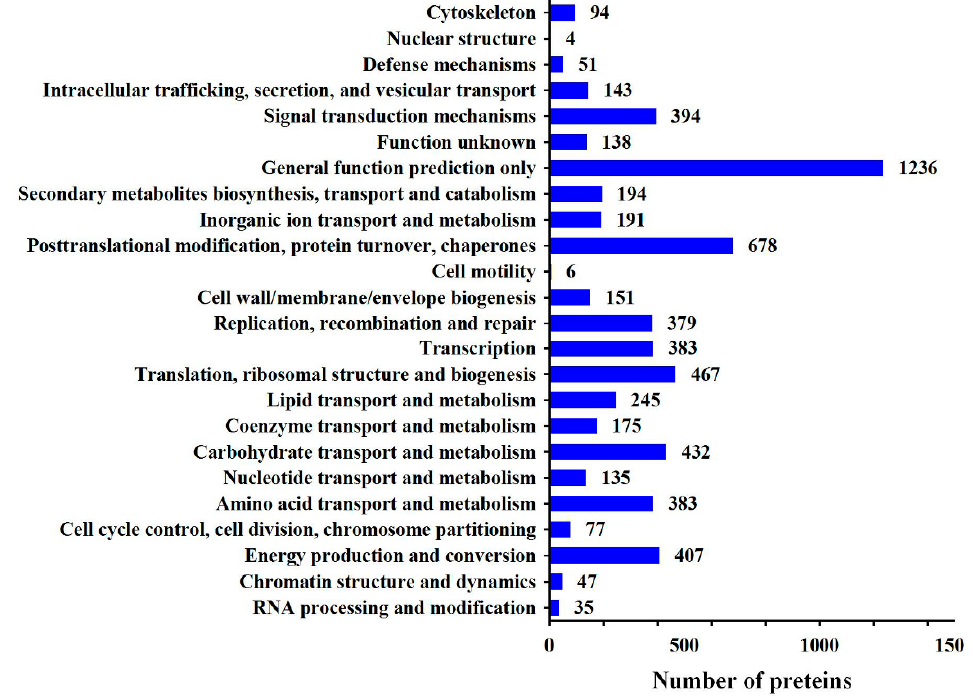
Figure 4. Cluster of Orthologous Groups of Proteins (COG) annotation analysis of all proteins.